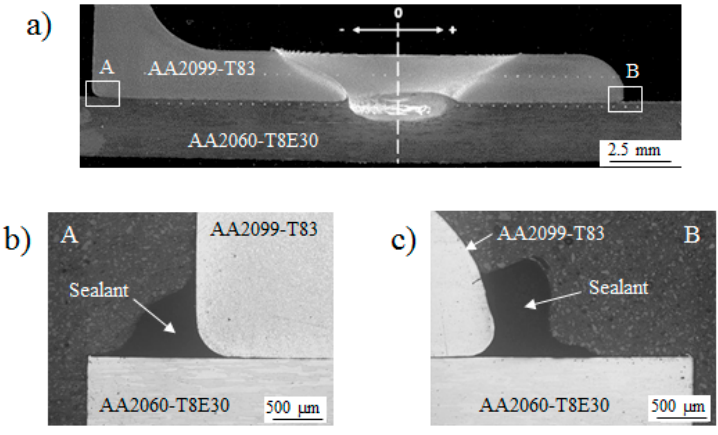
Figure 6. ( a ) Cross-sectional macrograph of the FSW weld in coupon C4; ( b ) magnified image of detail A in Figure 6a; and ( c ) magnified image of detail B in Figure 6a.